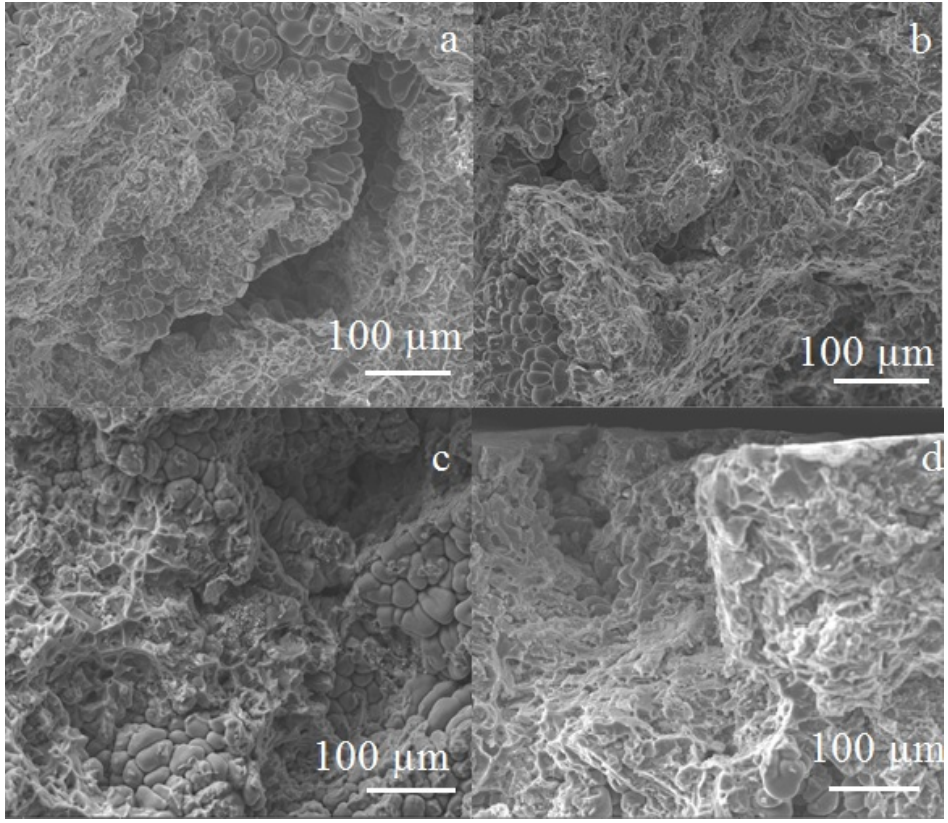
Figure 7. SEM images of the Al-Mg alloy fracture surface: ( a ) Al-5Mg, ( b ) Al-5Mg-0.3W, ( c ) Al-5Mg- 0.5W, and ( d ) Al-5Mg-0.8W.